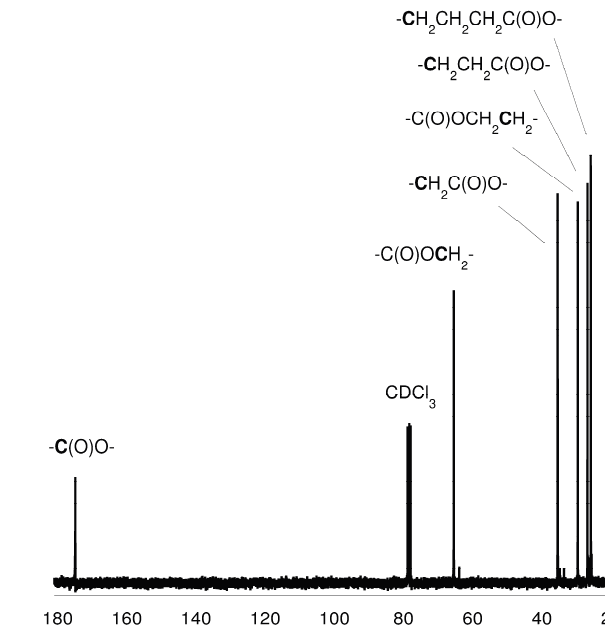
Figure 3. 13 C-NMR spectrum of the PCL (in CDCl 3 ).